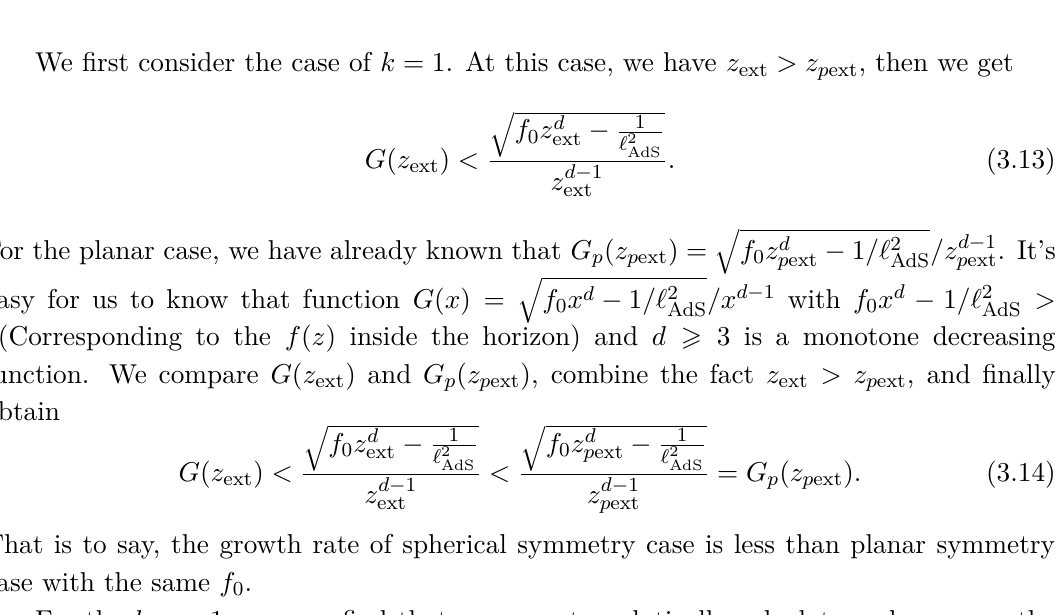
Figure 5 . For ‘ AdS = 1 , the vertical axis represents G ( z ext ) /G p ( z ext ) and the horizontal axis represents f 0